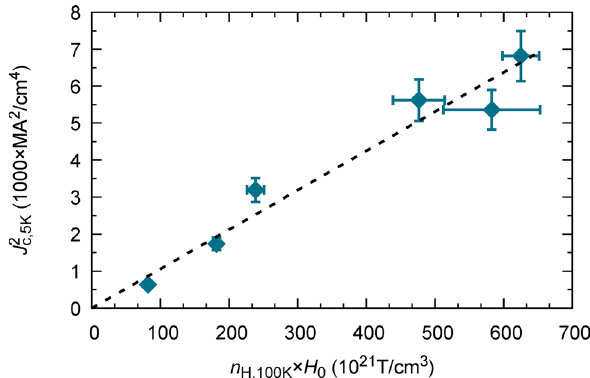
H 0 . The three parameters J c , n H and E C n H E c , using E c ∝ ∝